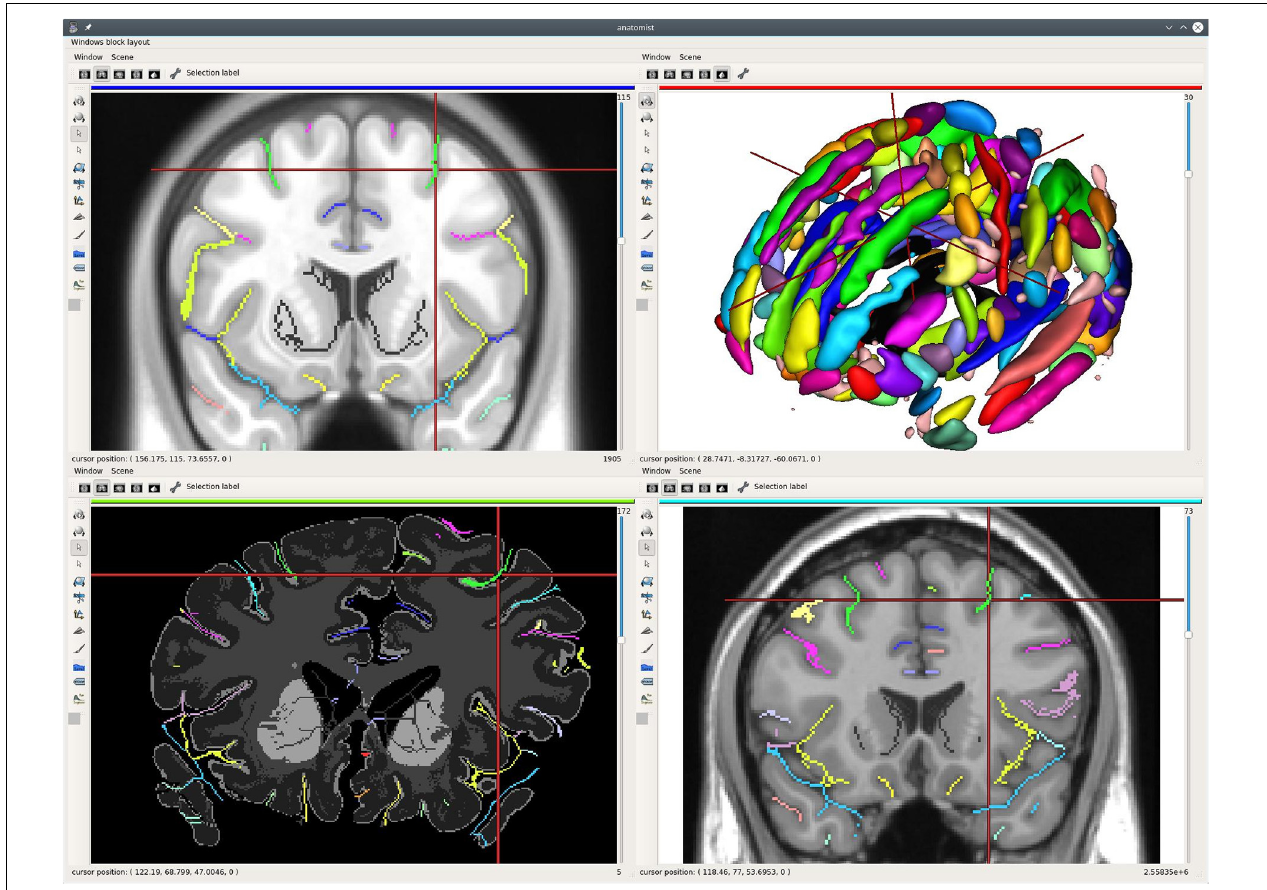
FIGURE 9 | Non-linear correspondence between different views and data. Three atlases and a sulci model representation are displayed. The ICBM152c asymmetric (top left), BigBrain (bottom left), and Colin27 (bottom right) templates are displayed, each in its native space, each with its own colored sulci set extracted using the Morphologist pipeline (in 2D here). Non-linear coordinates transformations apply between cursor positions in each view, thanks to DISCO/DARTEL transformation fields. The cursor position set by clicking on the superior frontal sulcus on the Colin27 image (bottom right) thus points to the same sulcus in the other templates’ views in different spaces, even when the atlas has large deformations such as on the postmortem BigBrain. Additionally, the sulcal model of Morphologist (top right) aligned to the ICBM152c space also displays the same sulcus at the cursor